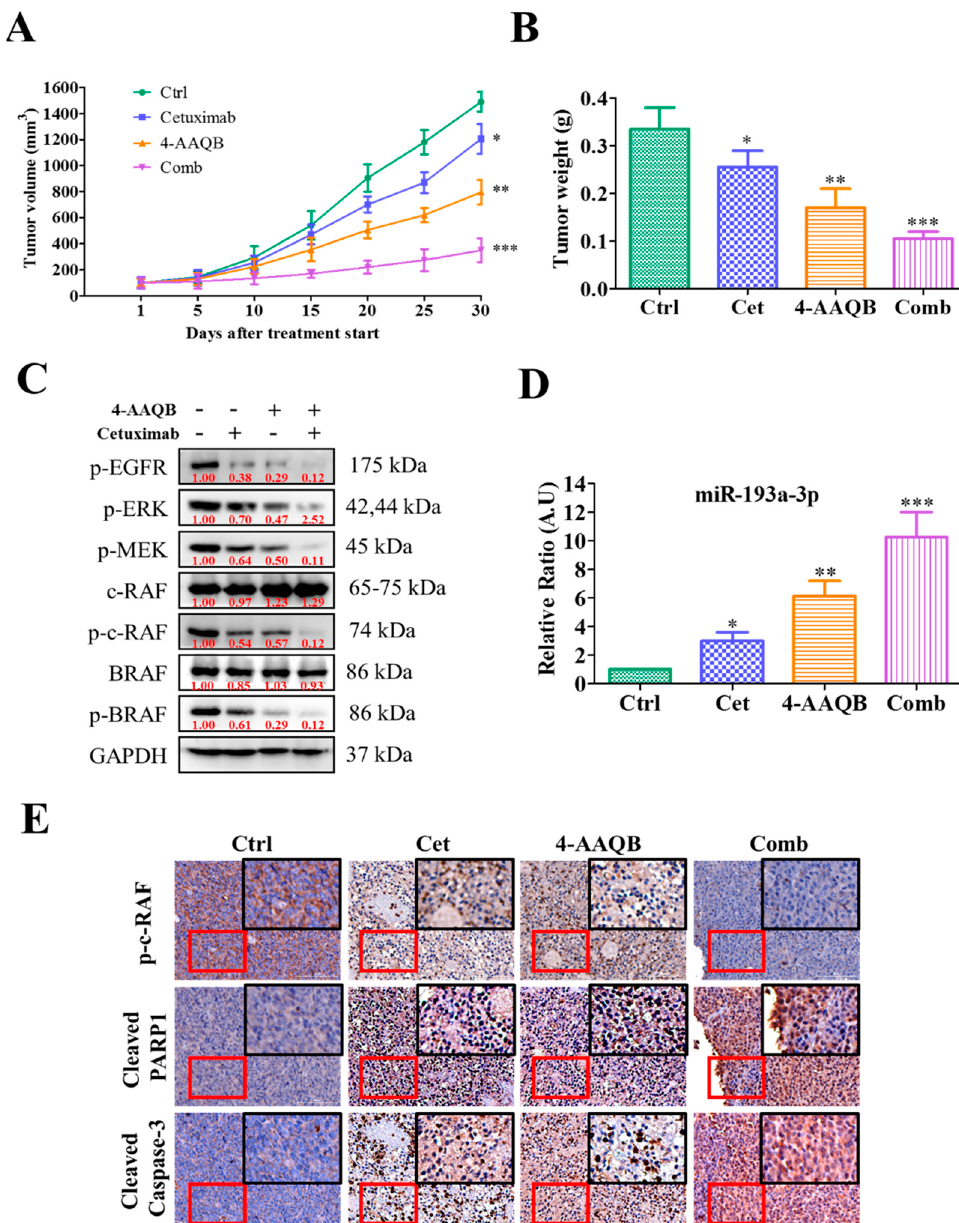
Figure 6. Efficacy evaluation of 4-AAQB by using a KRAS-mutant SW1463 xenograft mouse model. SW1463 tumor treated with the control, cetuximab, 4-AAQB, and combination of 4-AAQB and cetuximab. ( A ) Tumor volume (mm 3 ), ( B ) tumor weight (g), ( C ) Western blot analysis of the tumor sample. The expression of p-EGFR, p-ERK, c-RAF/BRAF, and p-c-RAF/BRAF were significantly downregulated in tumor treated with combination and alone 4-AAQB. ( D ) qPCR analyses of the plasma levels of miR-193a-3p. Pooled blood samples of all four groups of mice were analyzed for miR-193a-3p plasma levels. ( E ) Representative IHC staining of p-c-RAF, cl-Caspase-3 and cl-PARP in SW1463 xenografts treated with control, 4-AAQB, cetuximab, or cetuximab combined with 4-AAQB. * p < 0.05; ** p < 0.01; *** p < 0.001.